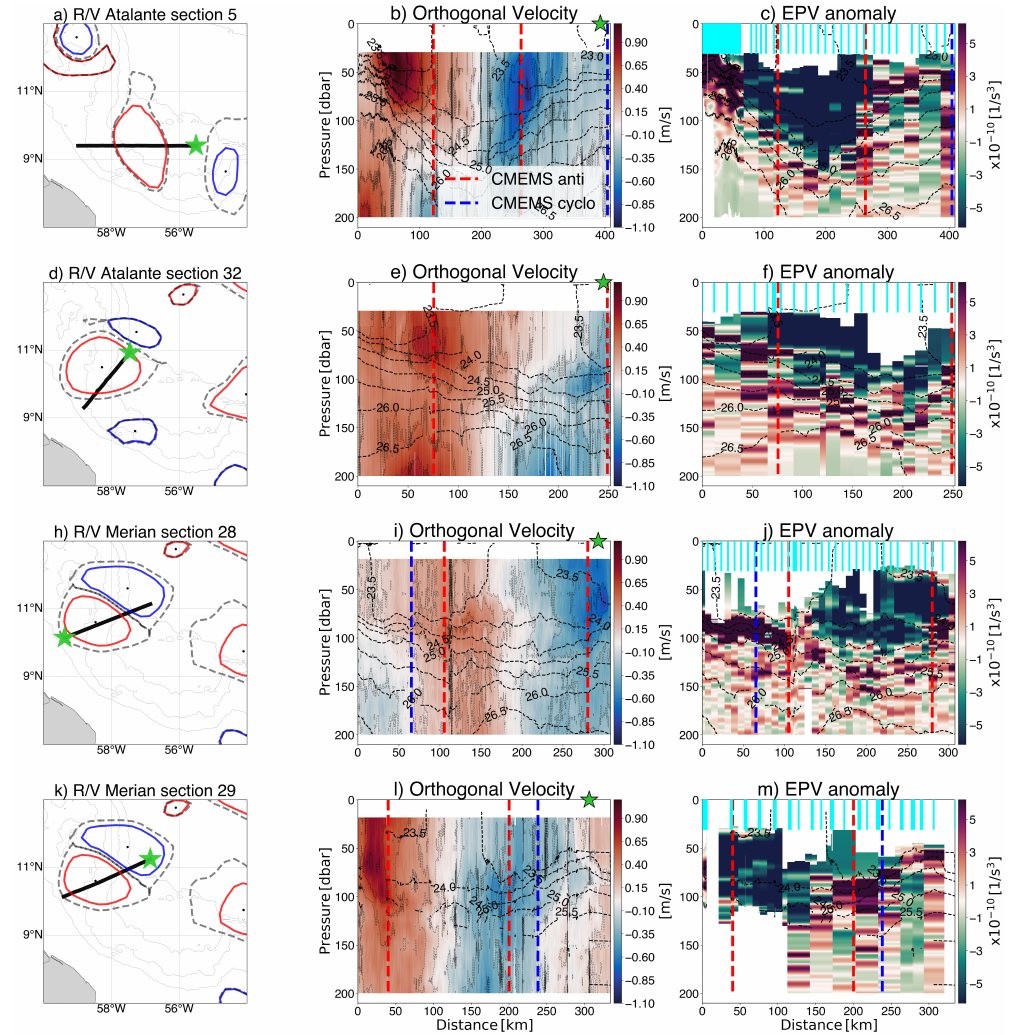
Figure 3. Ring A2 sections performed by R/V L’Atalante and R/V Maria S Merian during the EUREC 4 A-OA experiment. The first to fourth rows correspond respectively to the Sections 5 and 32 of RV/ L’Atalante, and 28 and 29 of R/V Maria S Merian (in chronological order). For each of the four sections, the first panels show the trajectory of the R/V in black, with the green star indicating the end of the section. Red and blue contours are indicative of the anticyclones and cyclones, respectively, detected by TOEddies. The second panel is the velocity, orthogonal to the section, measured by the S-ADCP, and the last panel represents the Ertel potential vorticity anomaly (EPVa) (see Section 2.1 for computation). The dotted black lines are isopycnals, computed by combining cross-validated CTD, uCTD, and MVP devices (the profile positions are indicated by cyan bars on the EPVa sections). The pink line varying vertically indicates that below it, only CTD measurements are represented. The red and blue vertical lines stand for the maximum velocity contours provided by TOEddies. On those four different sections, the surface intensified ring A2 detected by TOEddies is visible in the first 200 m, while a subsurface intensified ring is detected below